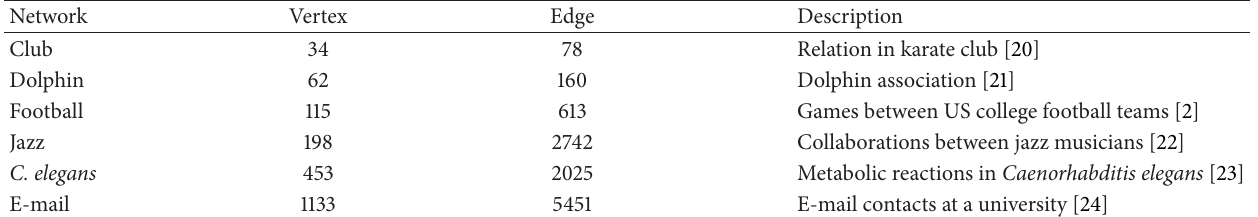
Table 3: Description of six real-world networks.